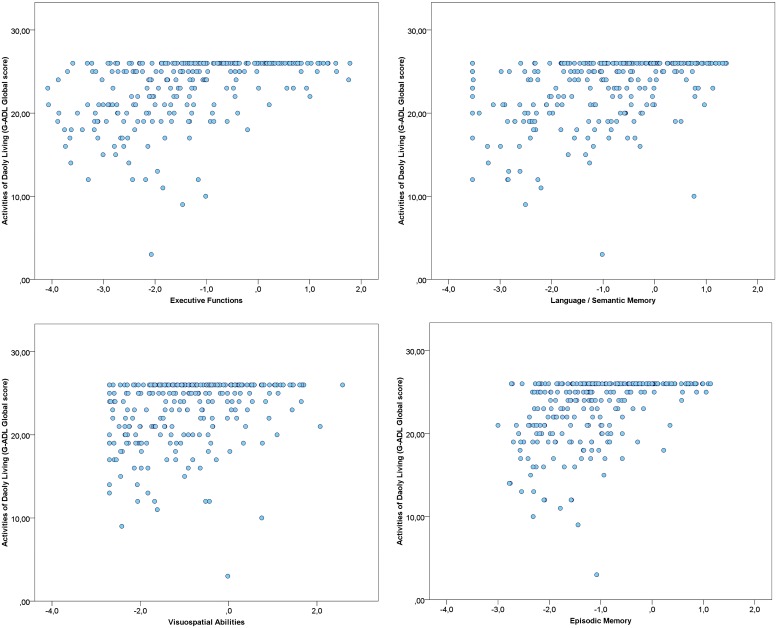
Association between Cognitive Factors and General Activities of Daily Living Scale (GADL). The correlations of cognitive factors with functional performance were all significant (p < 0.001). Executive functions showed the strongest correlation with GADL total score (r = 0.478), followed by episodic memory (r = 0.449), language/semantic memory (r = 0.410), and visuospatial abilities (r = 0.302). The number of dots in the scatterplot differs from the sample size due to superposed values.